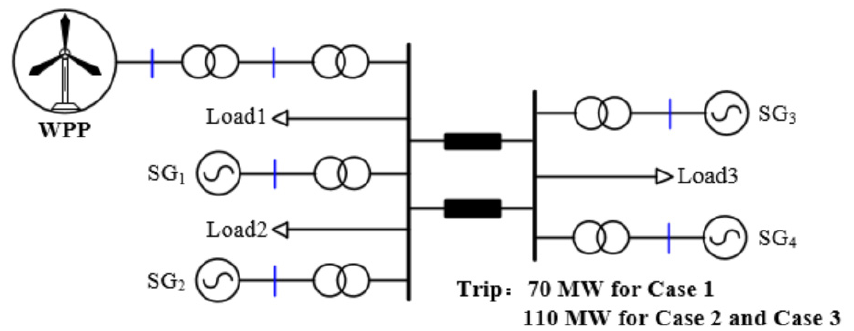
Figure 6. Model system embedded with a DFIG-based WPP.